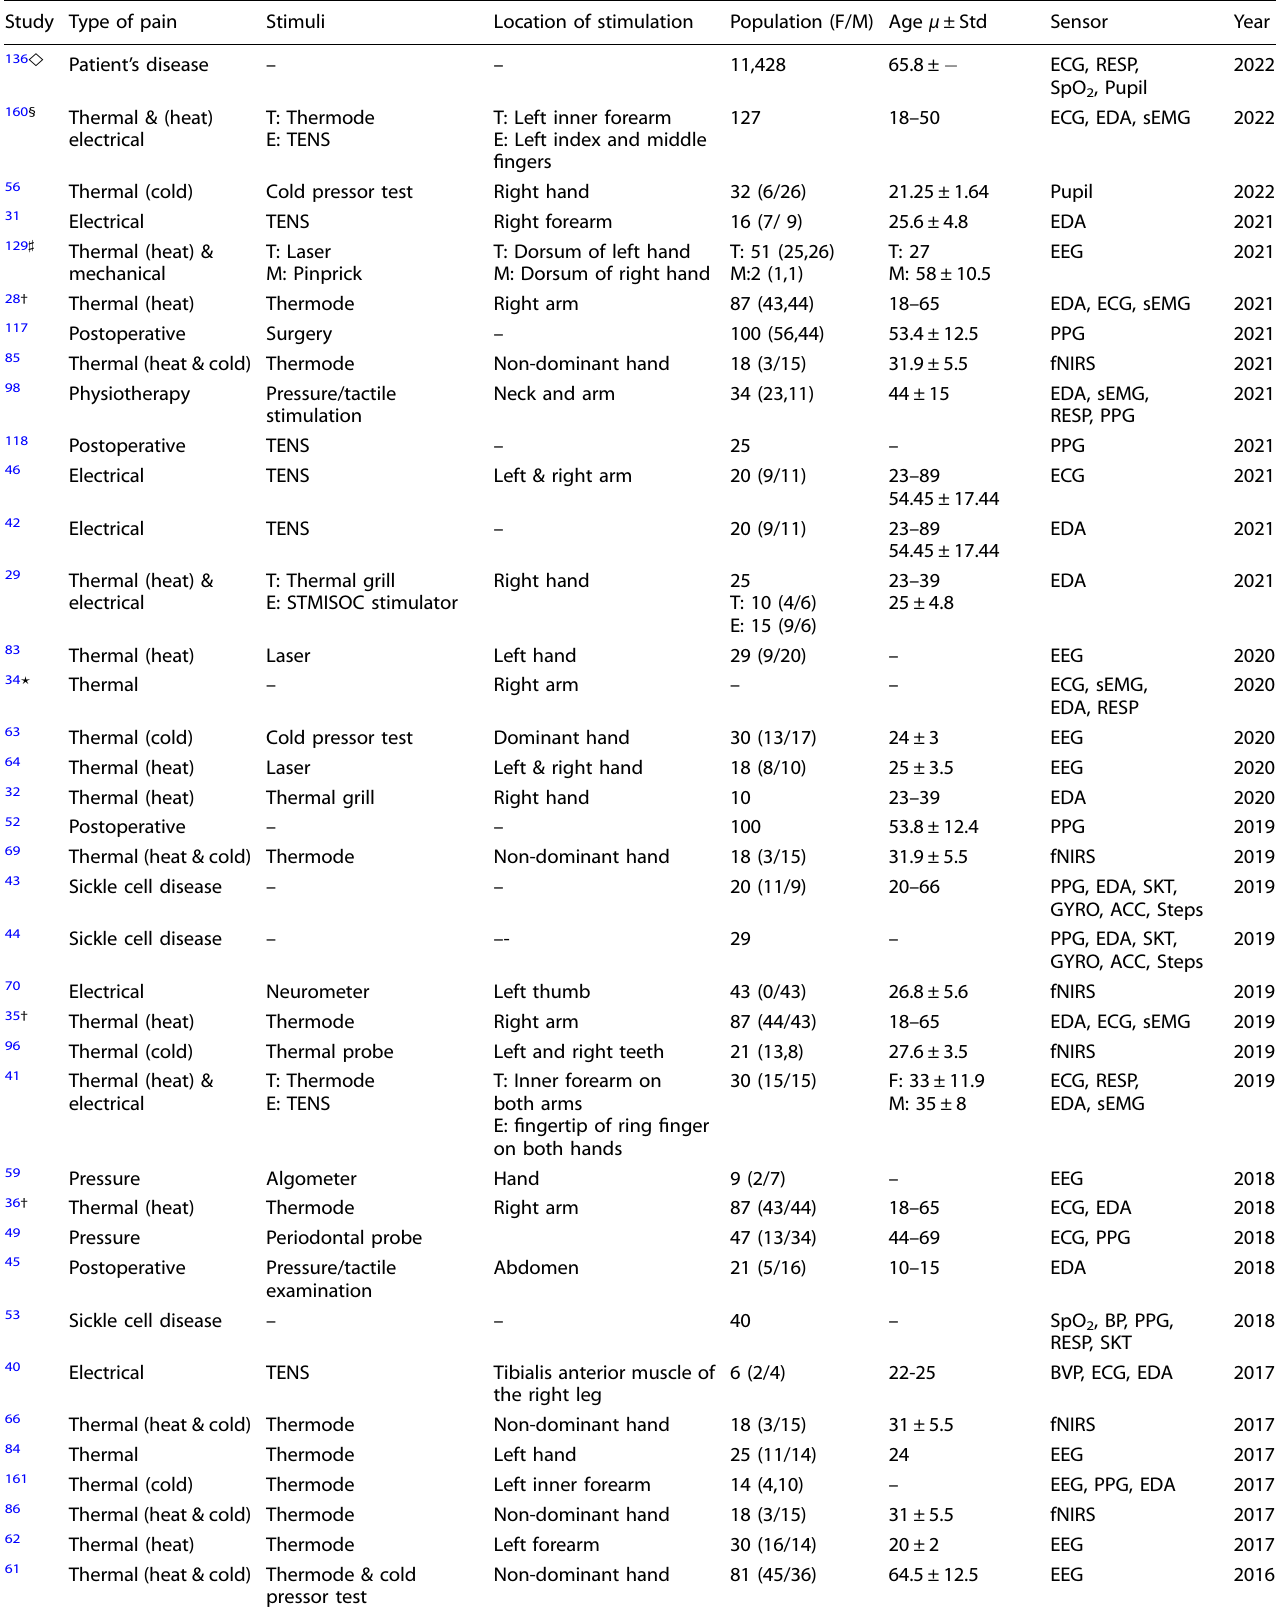
Table 1. Overview of reviewed studies in chronological order, their details and type of sensor used for pain